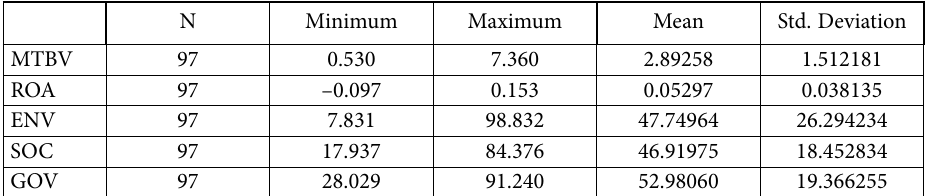
Table 3. Descriptive statistics (Europe) (source: own construction by using SPSS)